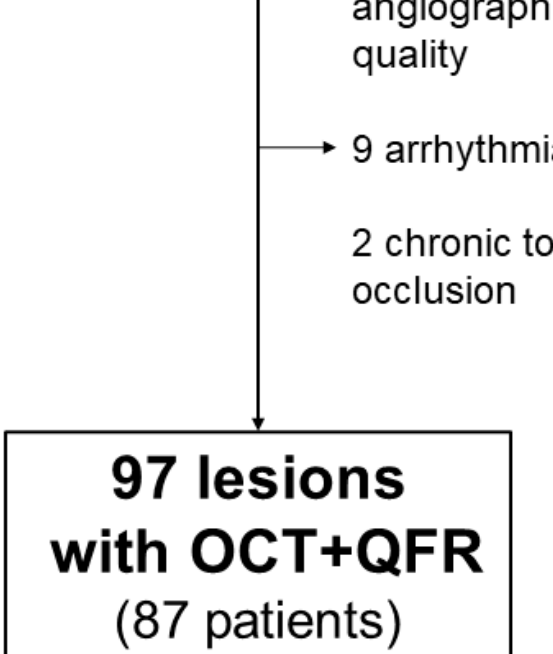
Figure 1 . Flowchart depicting study inclusion.